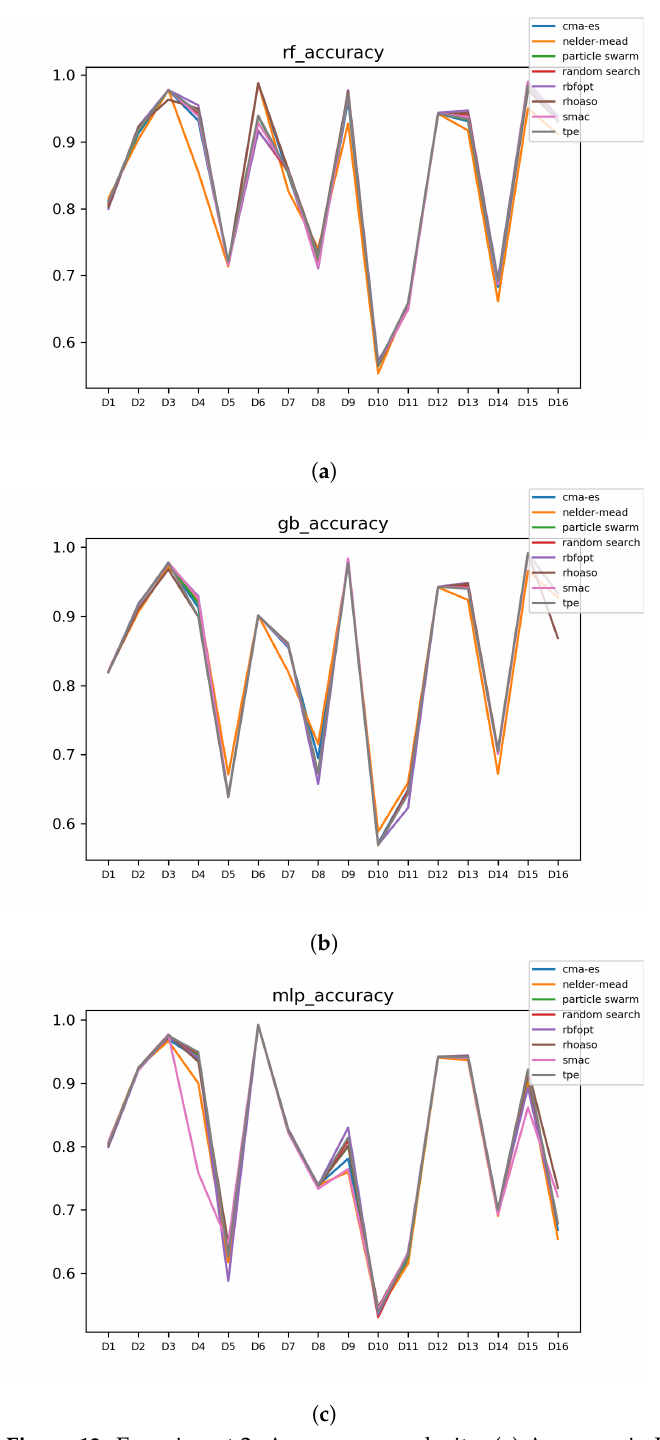
Figure 13. Experiment 2: Accuracy complexity. ( a ) Accuracy in RF. In axis X, the dataset. In axis Y, the accuracy obtained. Each line represents a HPO algorithm. ( b ) Accuracy in GB. In axis X, the dataset. In axis Y, the accuracy obtained. Each line represents a HPO algorithm. ( c ) Accuracy in MLP. In axis X, the dataset. In axis Y, the accuracy obtained. Each line represents a HPO